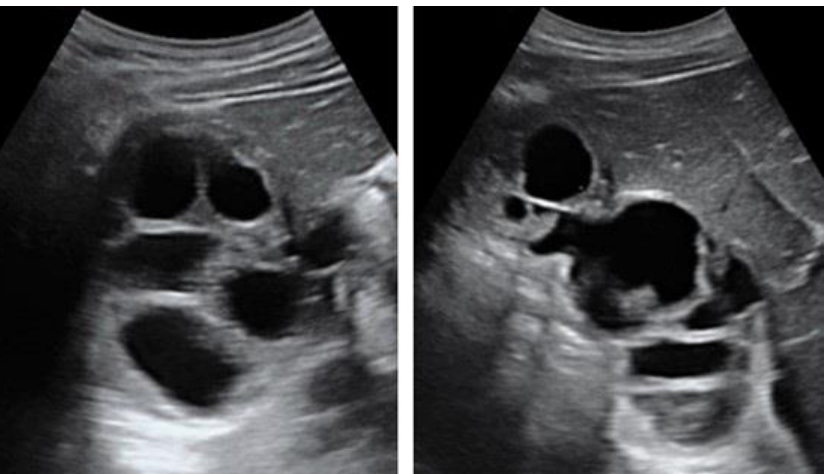
Figure 5. Ultrasound image of a 17-year-old female presenting with upper abdominal pain shows about an 11 × 6 cm well-demarcated, mild lobulated margin with multiple internal septations of higher attenuation seen in segment VI of the right lower hepatic lobe, descended in front, lateral to the right kidney, and exerting mild kidney indentation. Picture is in keeping with the hydatid cyst CE2 (WHO classification).